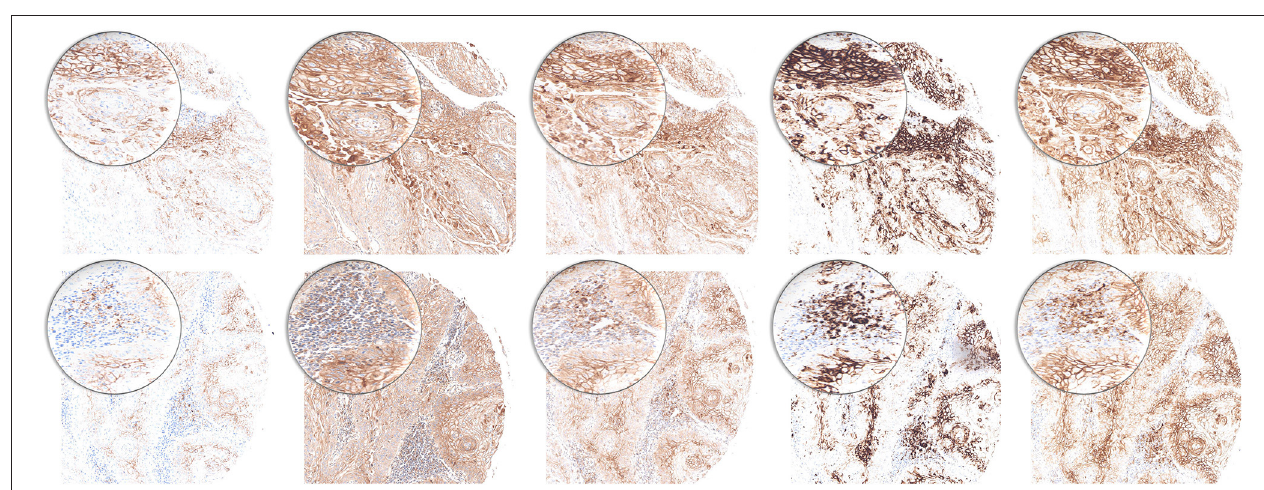
FIGURE 2 | PD-L1 staining pattern in HNSCC. Upper row: tumor cells. Lower row: immune cells. From left to right: 22C3, 28-8, E1L3N, SP142, and SP263. Original magnification x100. Inlay magnification x200.